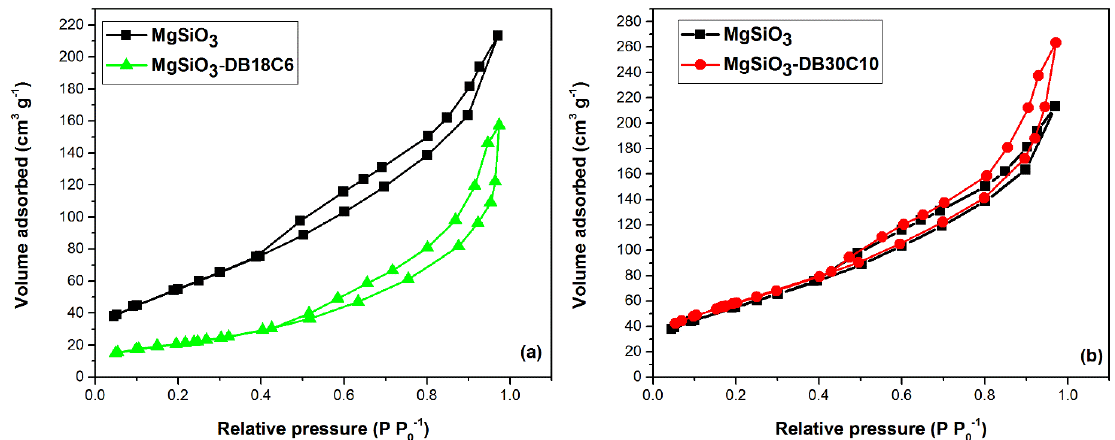
Figure 4. The N 2 adsorption–desorption isotherms: ( a ) MgSiO 3 and MgSiO 3 -DB18C6, ( b ) MgSiO 3 and MgSiO 3 -DB30C10.